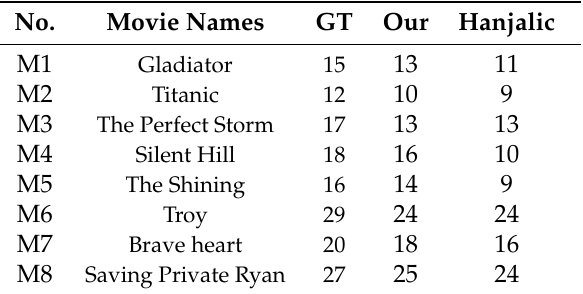
Table 4. Compared